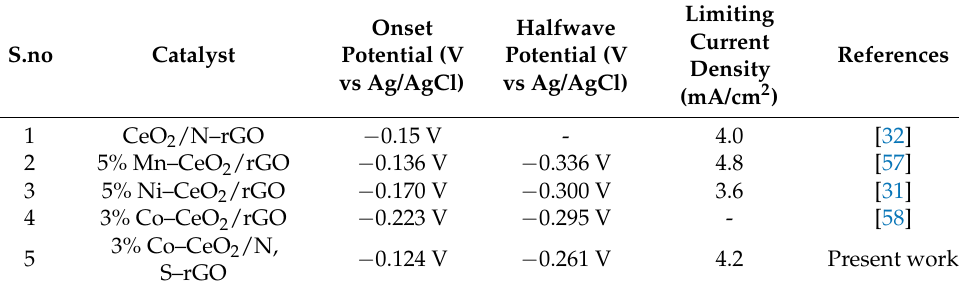
Figure 6. ( a ) LSV curves of CeO 2 and Co-doped CeO 2 ; ( b ) LSV curves of CeO 2 /N, S–rGO and Co-doped CeO 2 /N, S–rGO; ( c ) LSV curves of 3% Co–CeO 2 /N, S–rGO (at different rpm); ( d ) K–L plots of 3% CeO 2 /N, S–rGO. Table 1. Comparison of ORR activity of doped CeO 2 with rGO based catalyst.